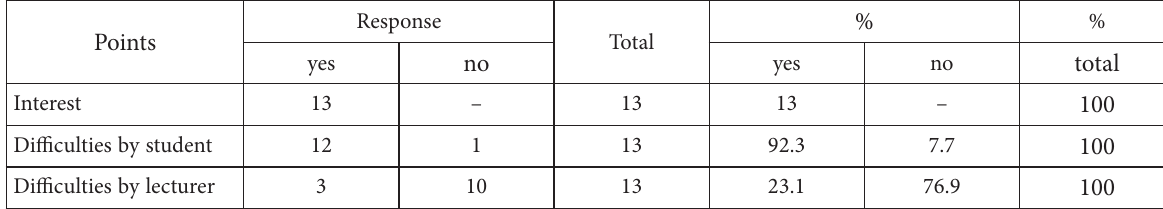
Table 8. Percentage distribution of lecturer